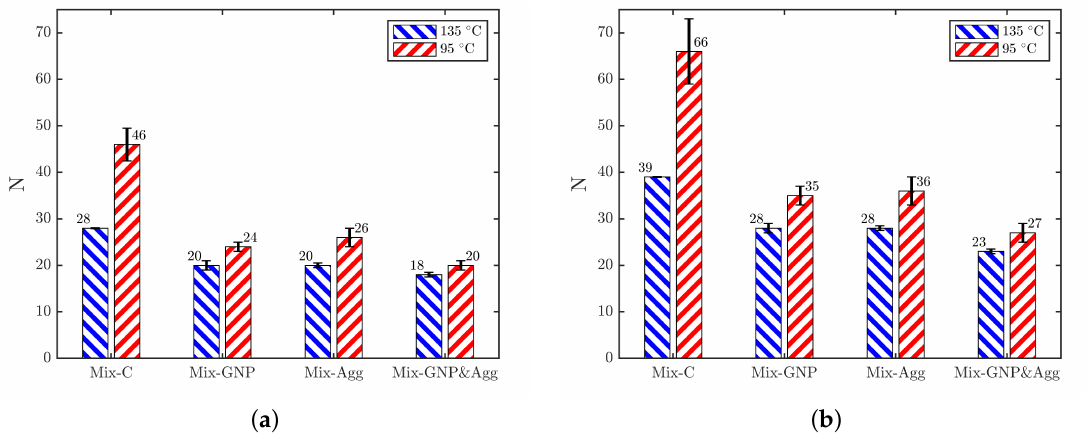
Figure 9. The numbers of gyrations needed for achieving the two density levels: ( a ) 93.9 %G mm and ( b ) 95 %G mm